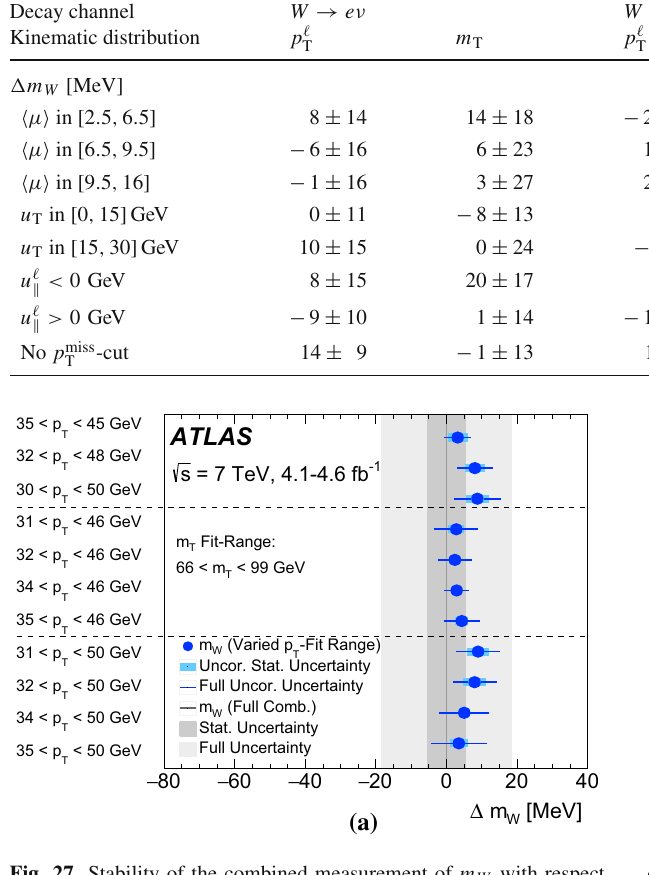
( m T ) are shown. The bands and T